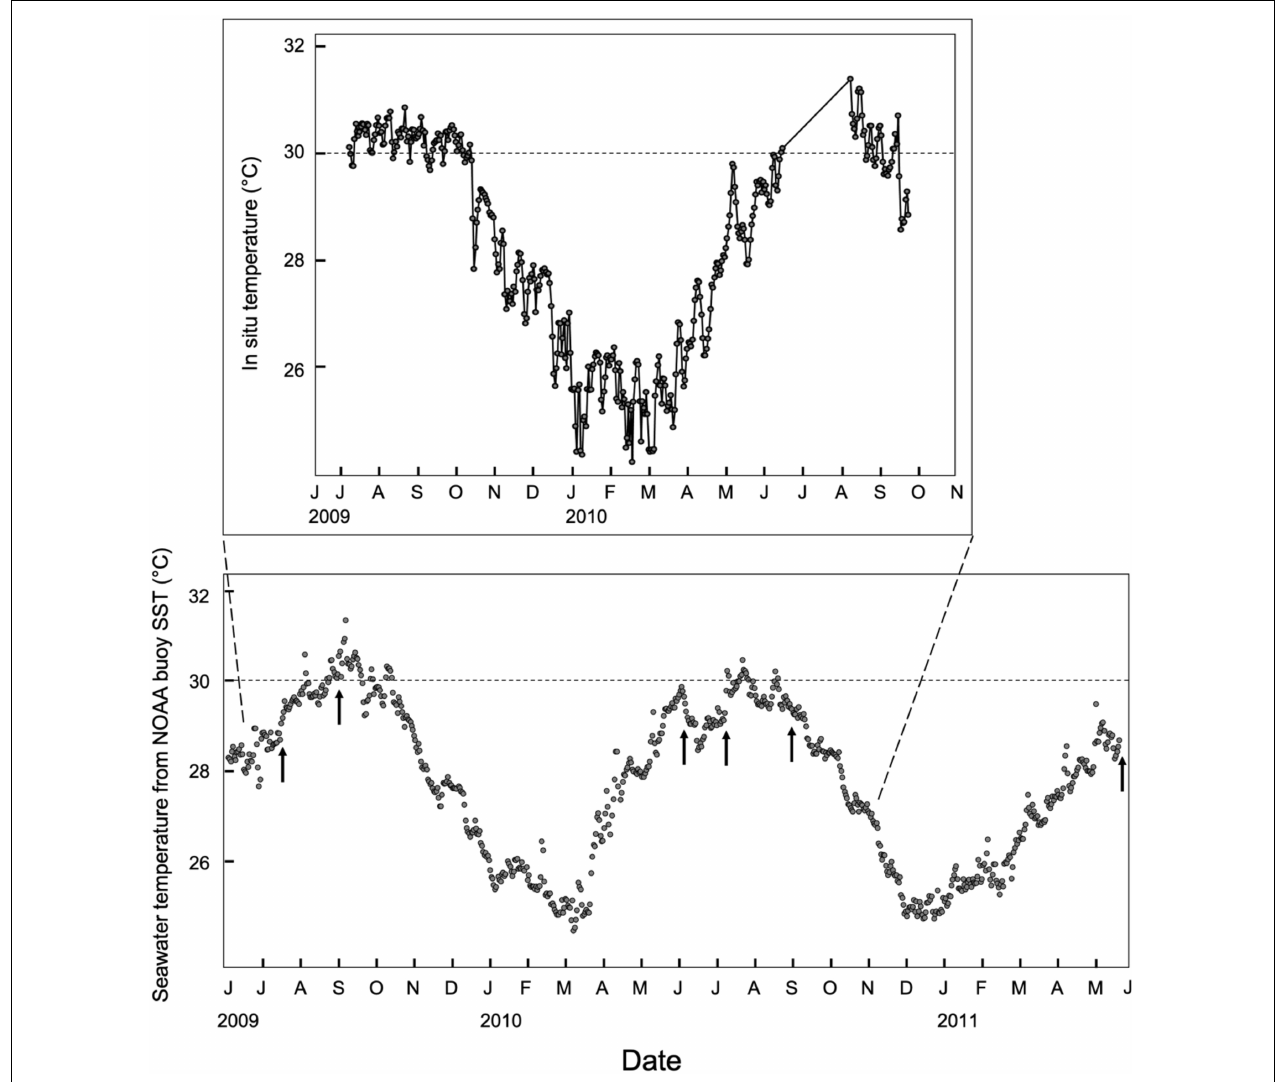
FIGURE 1 | Average daily seawater temperature records between June 2009 and June 2011 from the NOAA buoy station 42058 central caribbean at 2 m depth (14 ◦ 23 (cid:48) 20 (cid:48)(cid:48) N 74 ◦ 48 (cid:48) 10 (cid:48)(cid:48) W) and inset with in situ temperature from temperature loggers deployed on the reef at the common garden beside the corals between June 2009 and November 2010 (20 ◦ 52.8150N, 86 ◦ 50.9890W). The local bleaching threshold ( ∼ 30 ◦ C) is represented by the dotted line. Months are indicated by their first letter and the year is indicated at the first listed month for that year. The sampling times are represented by the